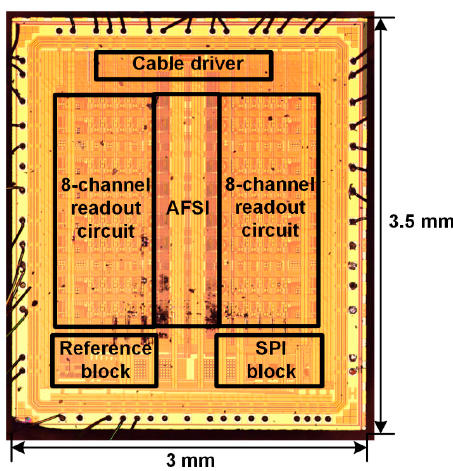
Figure 8. Microphotograph of the fabricated ROIC.